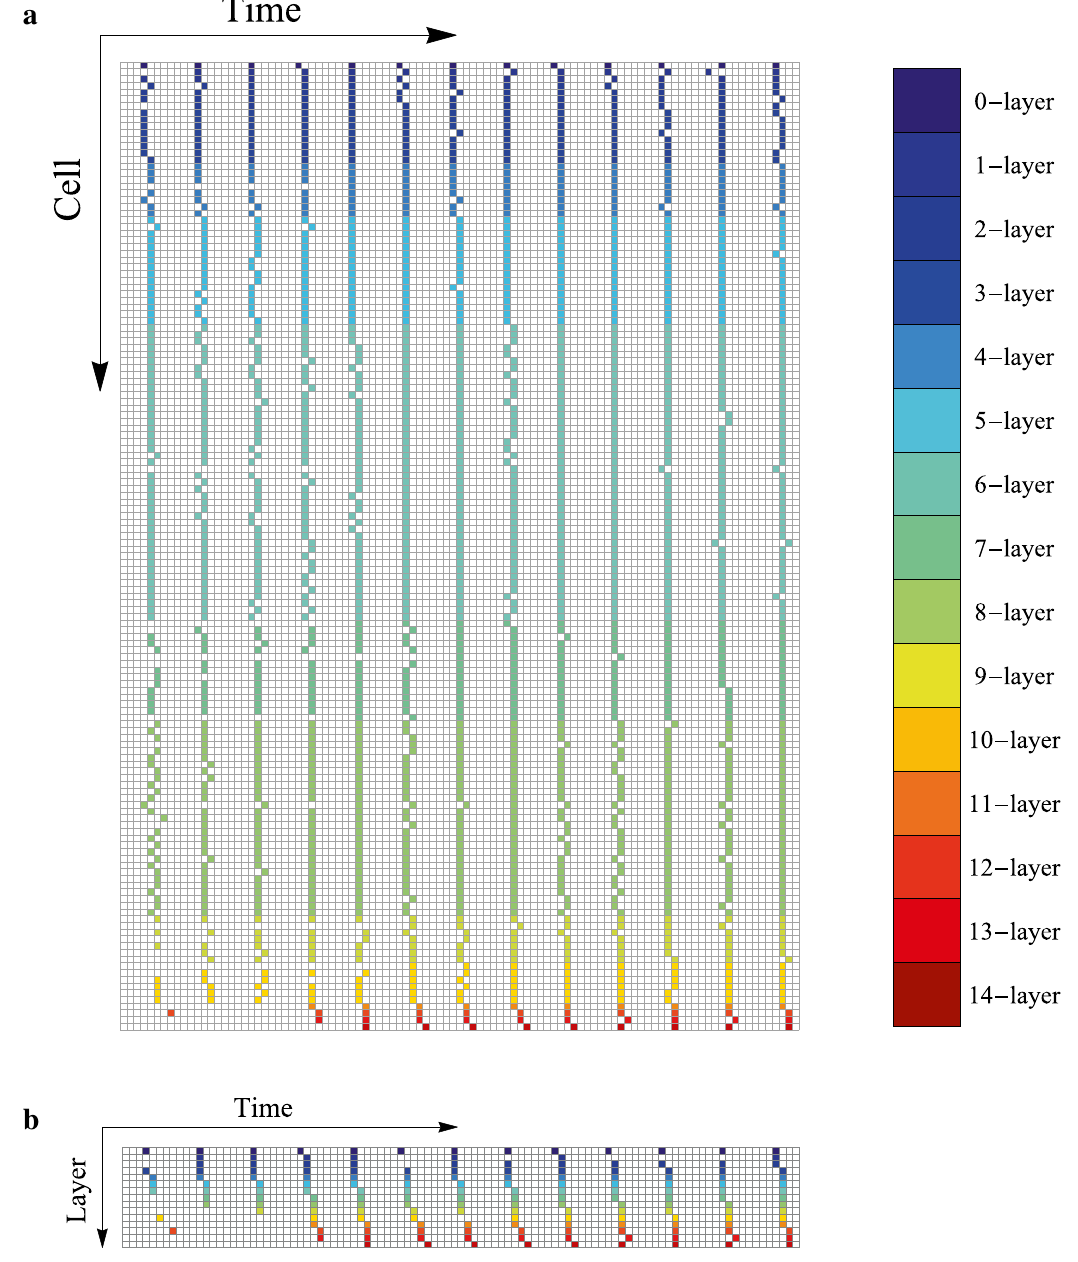
Figure 6. ( a ) { 0, 1 } -cell-state sequences for period I 4 . Each row represents the state sequence of the corresponding cell. Colored and blank states are firing (1) and non-firing (0) states, respectively, and color indicates each cell’s belonging layer. ( b ) Layer-consensus { 0, 1 } -cell-state sequences for period I 4 . The i th row represents the consensus state sequence among the i th layer cells, where the consensus state at time t means the majority state at that